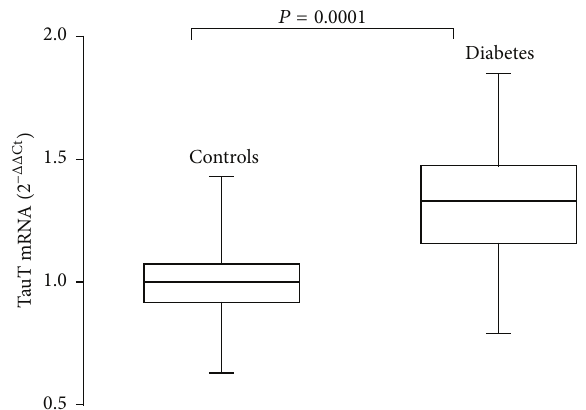
Figure 1: Box and whisker plots of TauT mRNA gene expression in mononuclear peripheral blood cells of type 1 diabetes patients and of